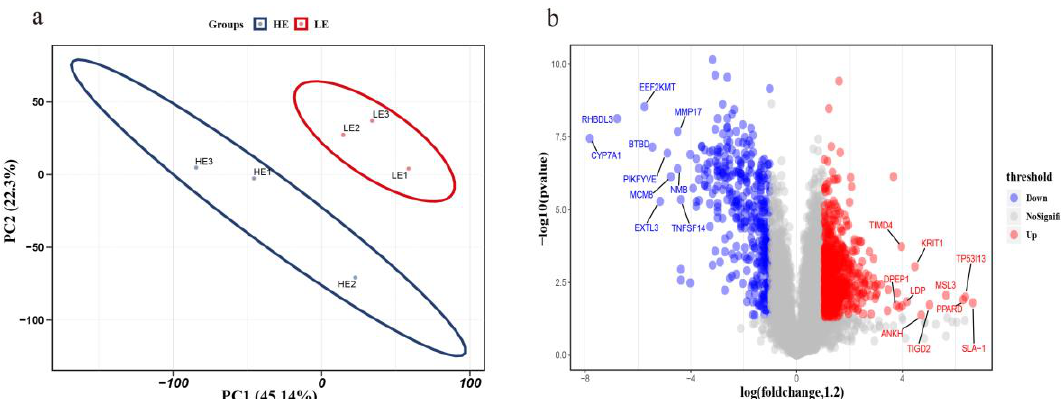
Figure 3. Differentially expressed protein analysis between high- and low-FE groups. ( a ) Principal component analysis of relative expression levels of proteins. The red and blue circles represent the low-FE and high-FE groups, respectively. ( b ) Volcano plot of differentially expressed proteins (DEPs) of the small intestine. The red and green dots represent up- and downregulated DEPs, respectively. Gray dots represent other detected proteins that do not meet the screening criteria.